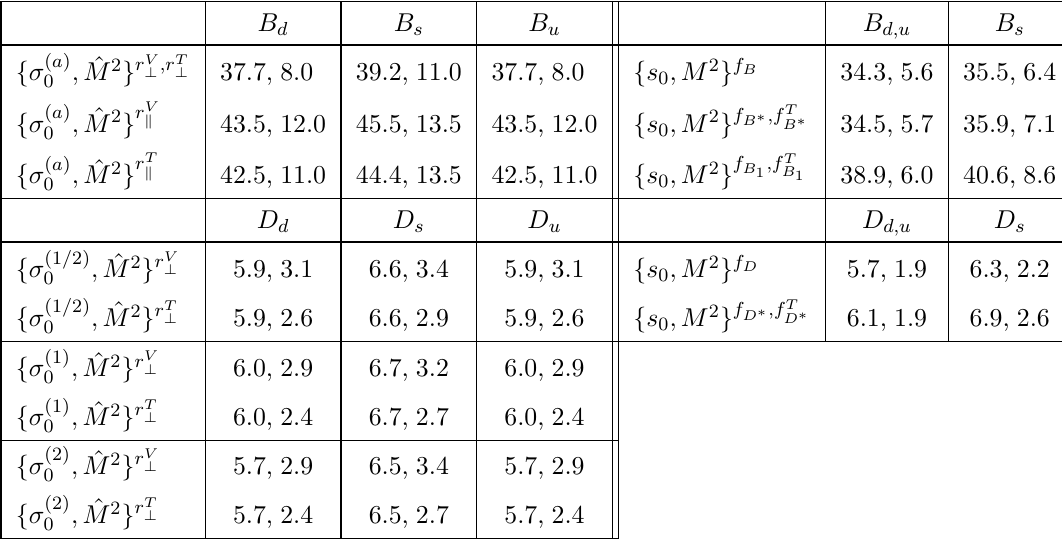
Table 2 . Summary of the SR parameters used in the determination of the residues for the triangular duality window a = 1 (cf. section 3.5.1 for comments). The additional threshold parameter is fixed via the ratio of the scalar and vector mesons. For the B -mesons ˜ t 0 / ˜ s 0 = m 2 ˜ t 2 /m 2 ≈ 1 . 18 in the ⊥ and k directions respectively. In the D -meson channels ˜ t 0 / ˜ s 0 = 0 / ˜ s 0 = m B 1 B m 2 /m 2 ≈ 1 . 15 . Note the difference between the values of σ ( a ) D ∗ D